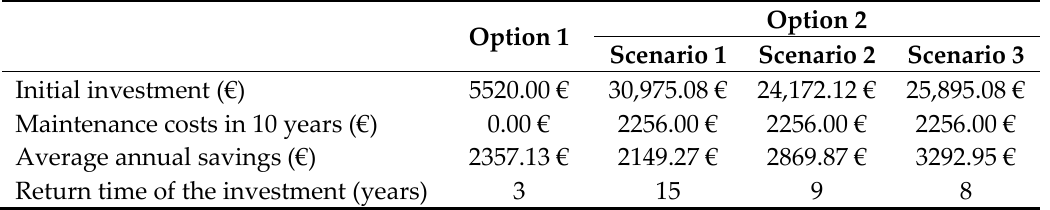
Table 3. Average annual savings and return time of the